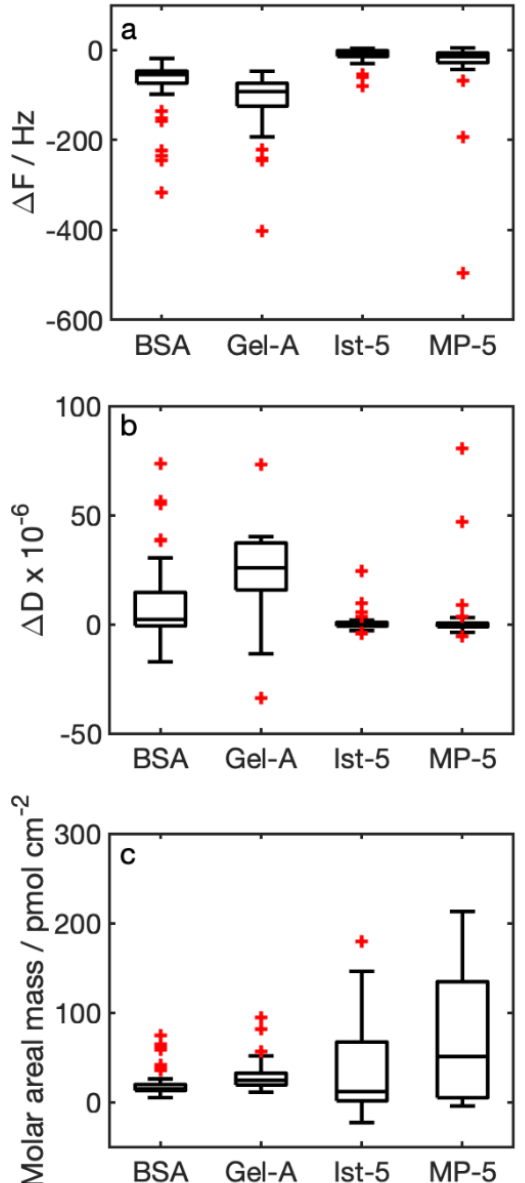
Figure 3. Characterization of SAM: ( a ) Δ f (F3), ( b ) Δ D (D3), and ( c ) molar areal mass calculated with the Sauerbrey model; the number of experiments for the statistical analysis is 39 for BSA, 32 for Gel-A, and 30 for Ist-5 and MP-5. Red crosses are values out of the interquartile range multiplied by